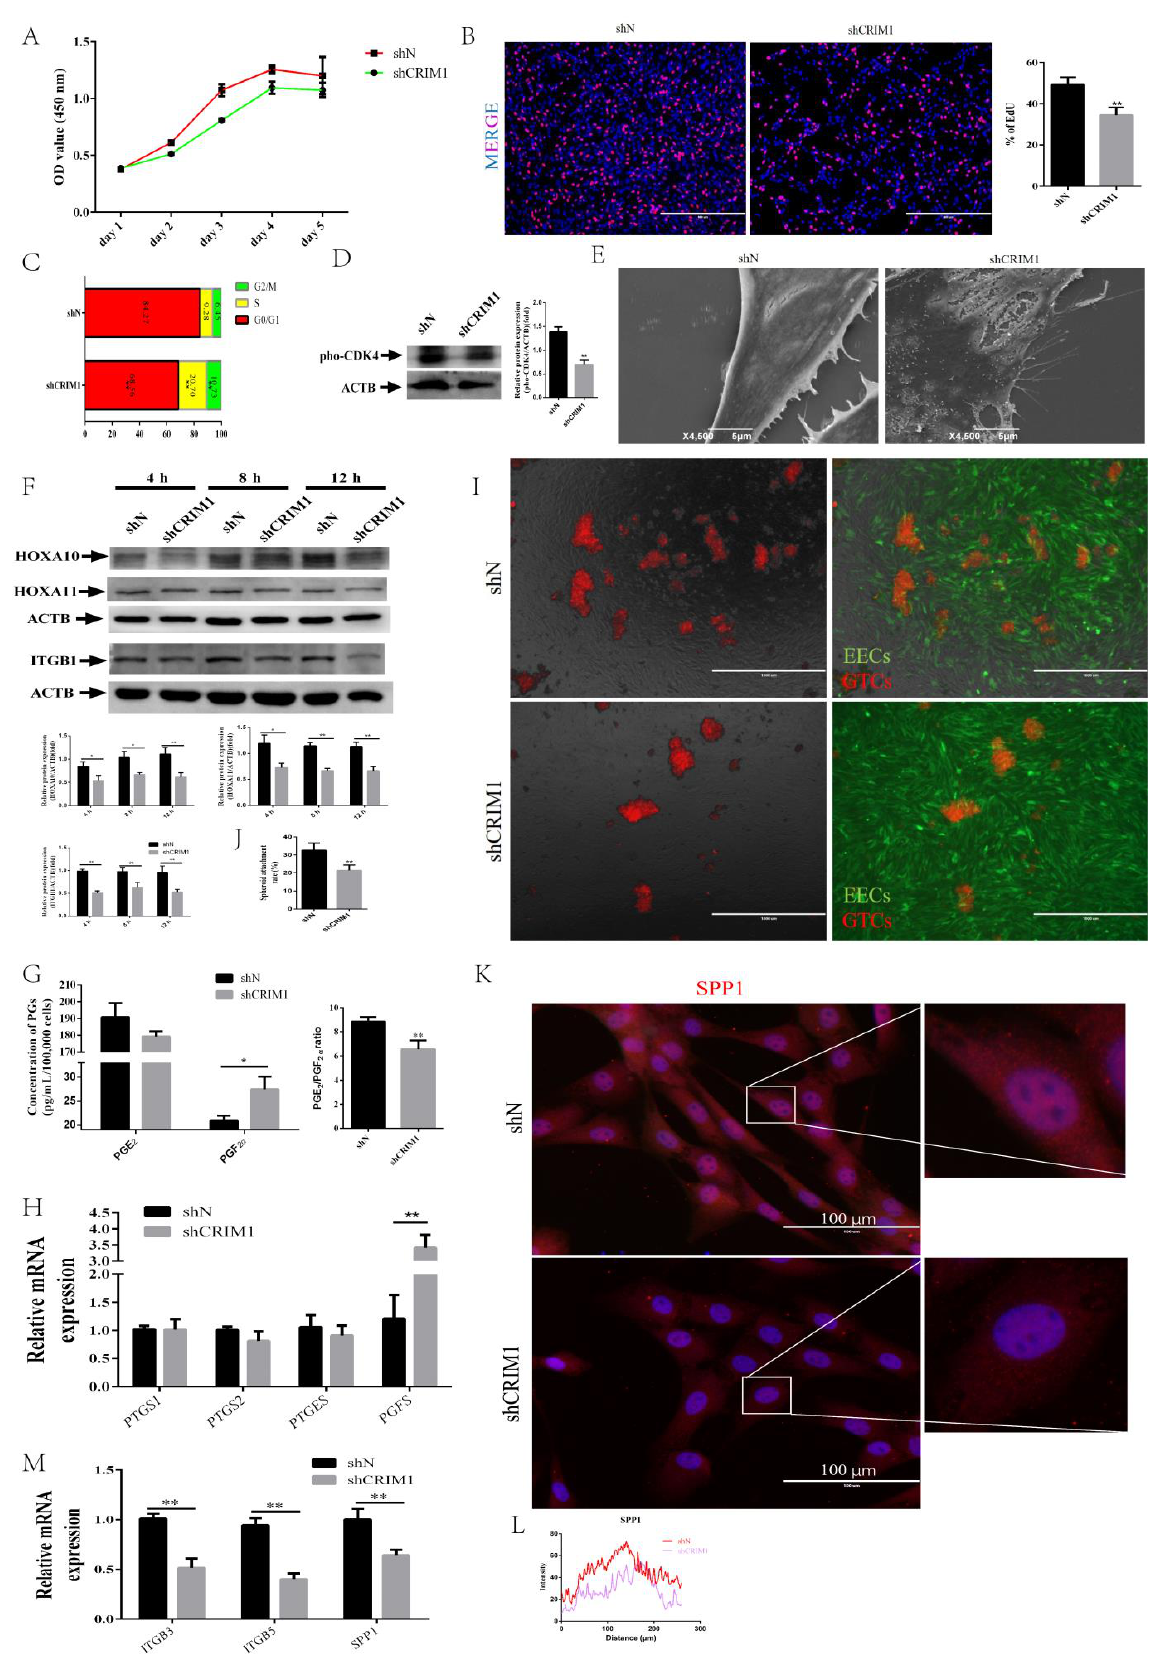
Figure 3. Knockdown of CRIM1 jeopardized endometrial receptivity. EECs were infected with a lentivirus specific for CRIM1 and shN for 48 h under P 4 , E 2 and IFN- τ treatment. ( A ) Growth curves of the shN and shCRIM1 groups